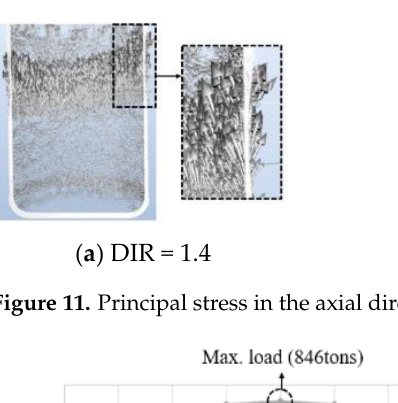
Figure 10. Fracture tendency according to the DIRs.